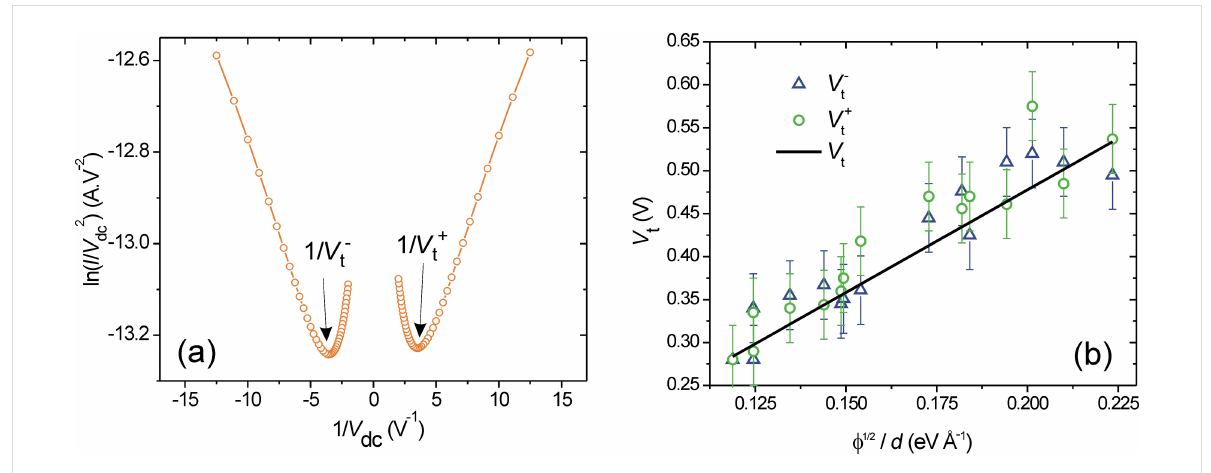
Figure 4: (a) Fowler–Nordheim representation of the J T ( V dc ) data shown in Figure 3a. The transition voltages and are determined from the inflection points of the representation. (b) and as functions of for 15 electromigrated junctions. The solid line is the transition voltage V t calculated with Equation 5 and the parameters and d deduced from Simmons’ fit of the electrical